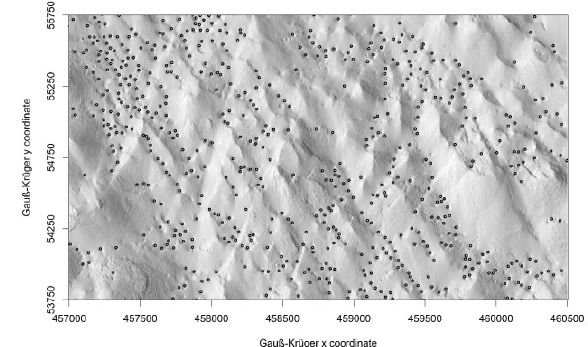
Figure 6. Spatial distribution of 1 st rank sinkholes over the study area – a directionality towards north-west south-east axis is visually